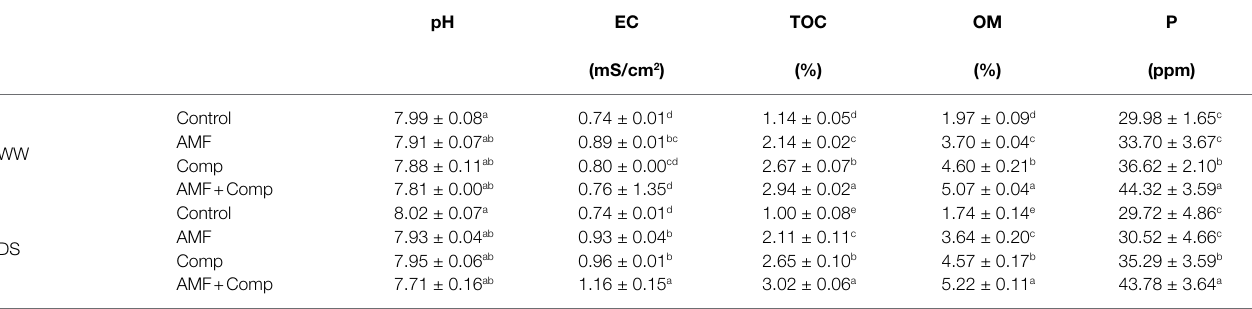
TABLE 5 | Main characteristics of different treatments on agricultural soil physicochemical parameters after harvest. pH EC